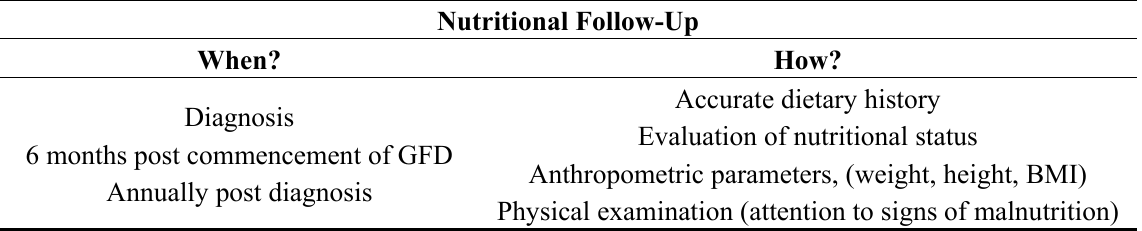
Table 4. Recommended timing for nutritional follow-up. BMI: body mass index.